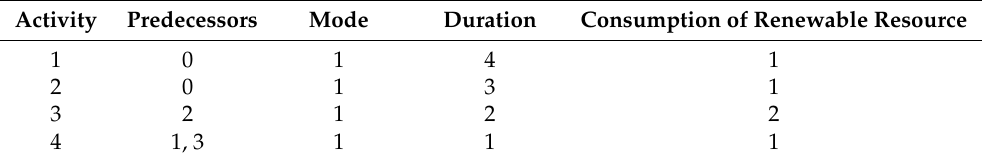
Table 1. Parameters of a sample project.